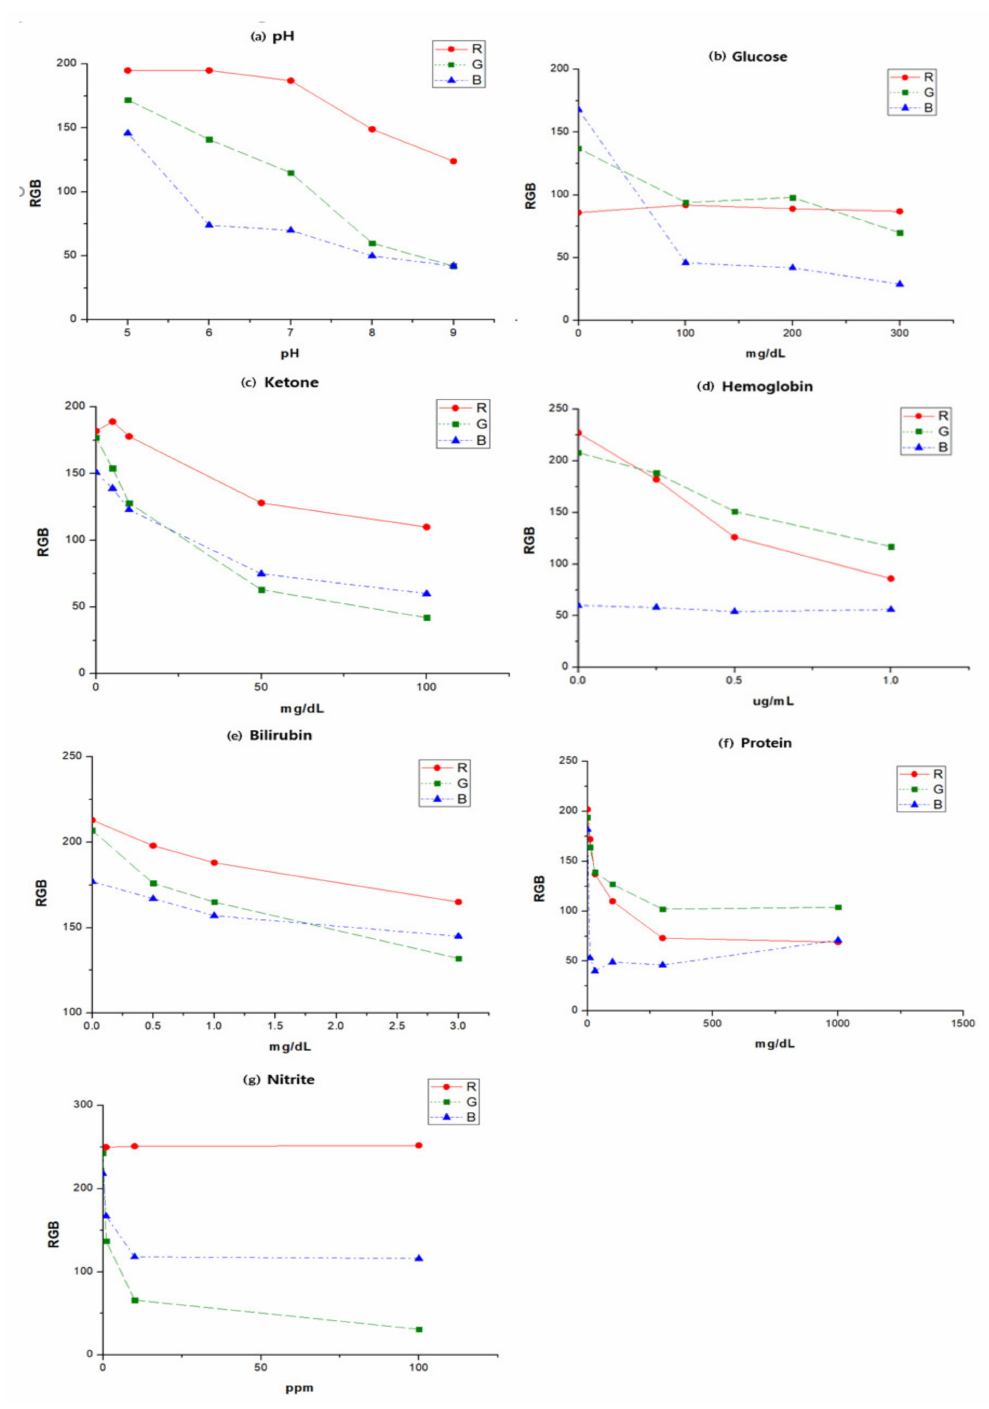
Figure 3. RGB change values for concentrations in the urine